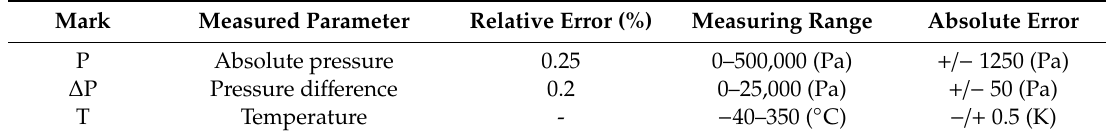
Table 1. Summary of parameters being measured with respective accuracies.